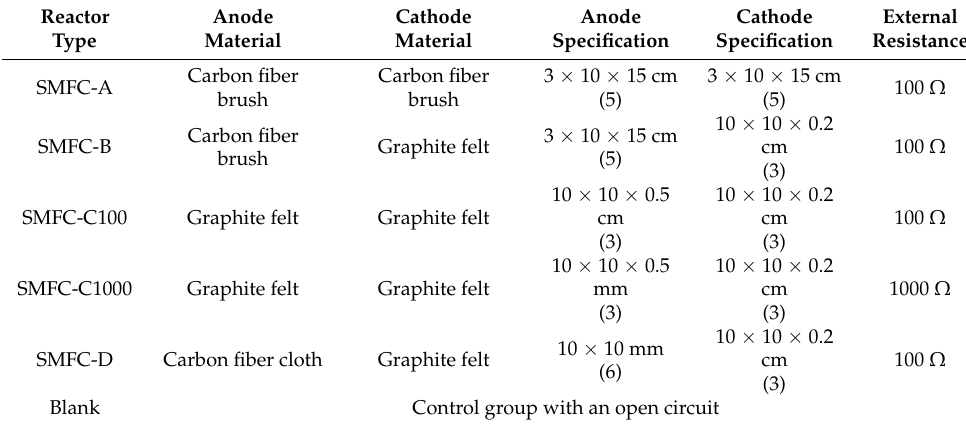
Table 1. SMFCs with various